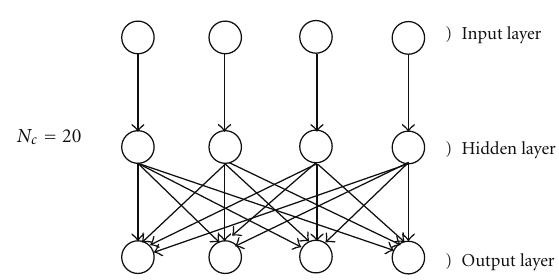
Figure 1: An example of an AutoCM with N =